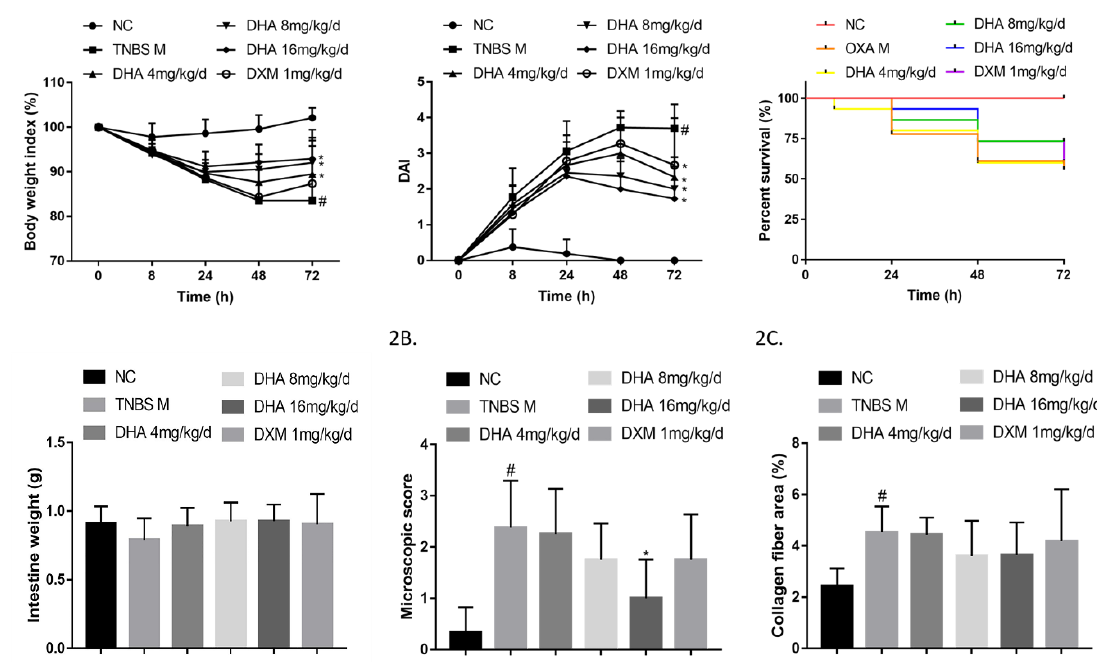
Figure 2. Dihydroartemisinin (DHA) ameliorates 2,4,6-trinitro-benzene sulfonic acid (TNBS)-induced colitis in a dose-dependent manner in vivo. ( 2A ) Inflammatory bowel disease (IBD) was elicited in mice via TNBS intracolonic application. Body weight index, disease activity index (DAI) score, mortality, and intestine weight of each group are shown ( n = 15–18). ( 2B) Microscopic scores of colon H&E-stained images in each group are shown ( n = 7–9). ( 2C ) Percent collagen fiber areas based on images of Sirius Red stained intestines in each group are shown ( n = 7–9) (Cmpared to the NC group, # p < 0.05, compared to the model group, * p <0.05).